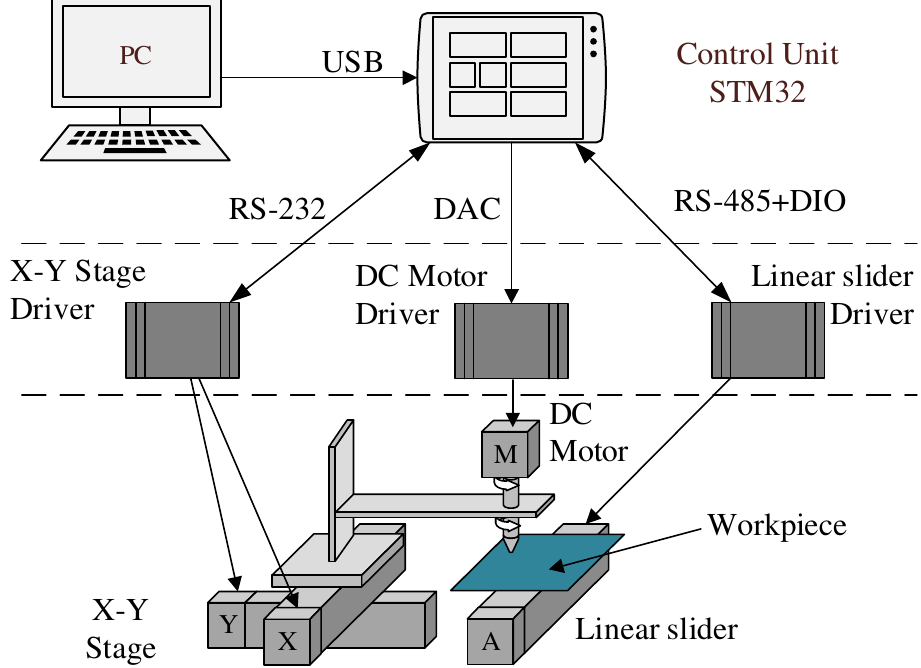
Figure 4. Schematic of experimental setup.